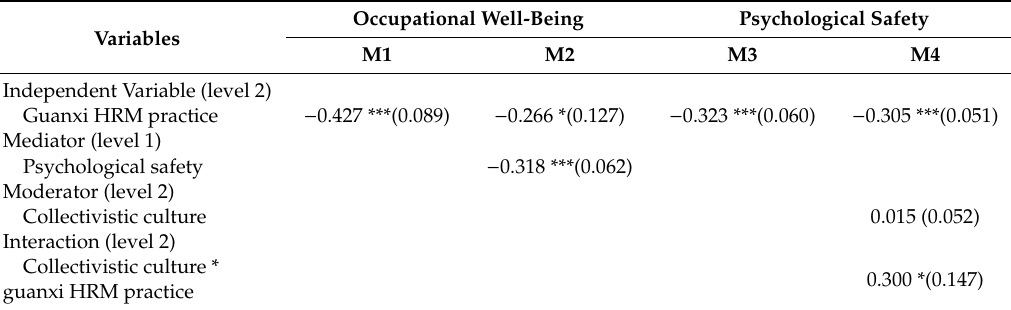
Table 2. Regression results for main, mediation and moderation e ff